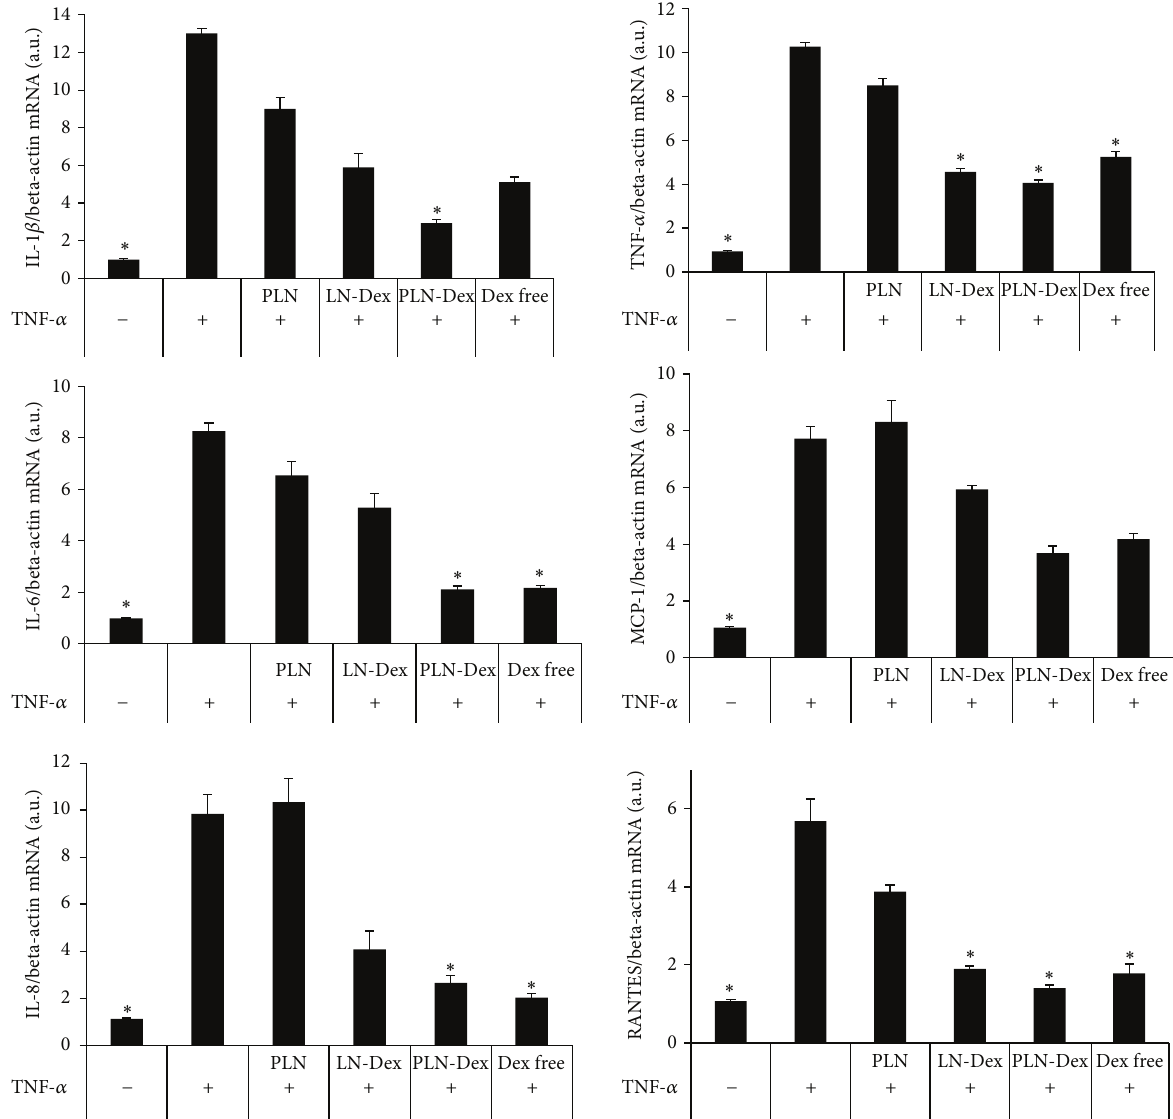
Figure 2: The anti-inflammatory effect of free dexamethasone (Dex) or encapsulated in nontargeted (LN-Dex) or P-selectin targeted (PLN- Dex) lipid nanoemulsions assessed by the expression of mRNA of several proinflammatory molecules in TNF- 𝛼 activated EC by quantitative RT-PCR and normalized to beta-actin mRNA. Empty PLN were used as control nanoemulsions. Results are expressed as fold induction over the quiescent EC (in the absence of TNF- 𝛼 ), considered as 1. The data from 3 up to 6 experiments are expressed as mean ± SD. ∗ 𝑝 < 0.05 significantly different from TNF- 𝛼 activated